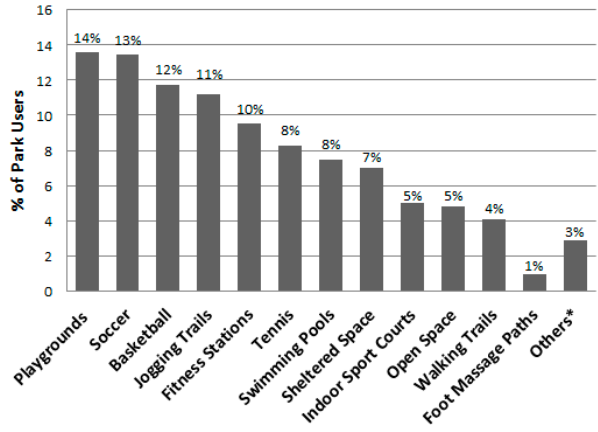
Figure 8. Percent of park area users by area type ( n = 28,585). * Others include archery range, climbing wall, gateball courts, lawn bowl greens, and roller-skating areas.